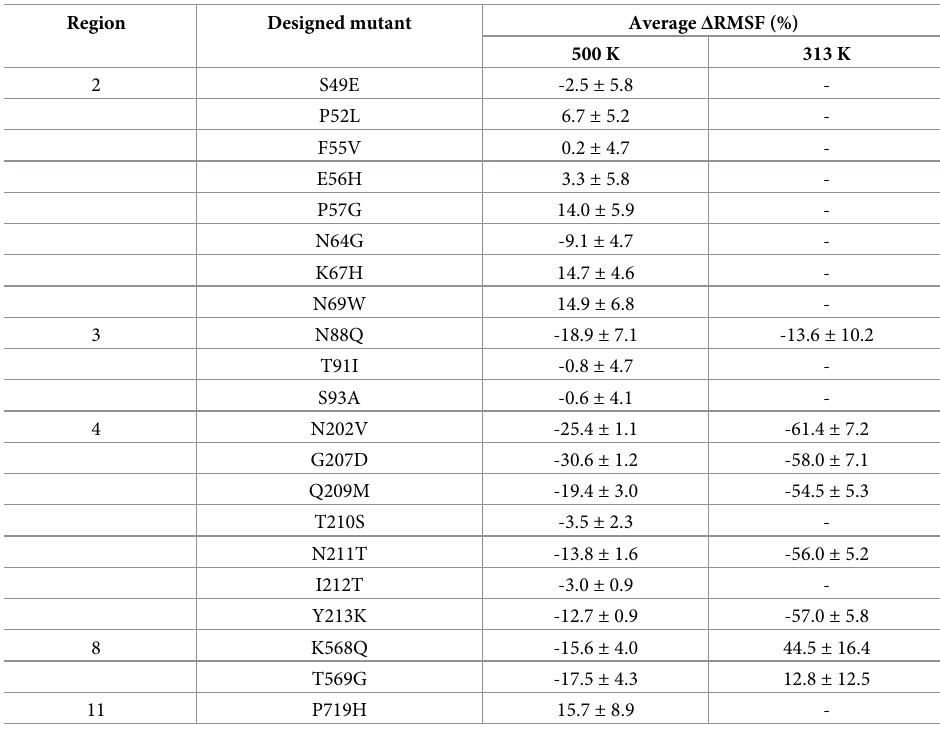
Table 3. The average Δ RMSF of designed mutants after simulations at 500 and 313 K. Region Designed